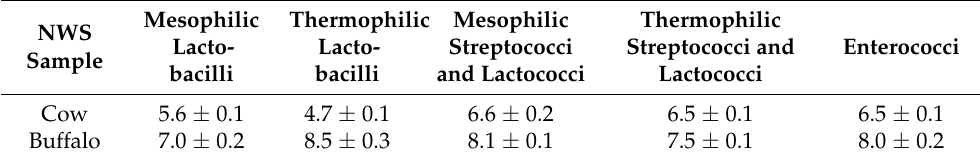
Table 3. Cell numbers * (log CFU mL − 1 ) of presumptive lactic acid bacteria groups found in the natural whey starter cultures (NWS) of cow or buffalo